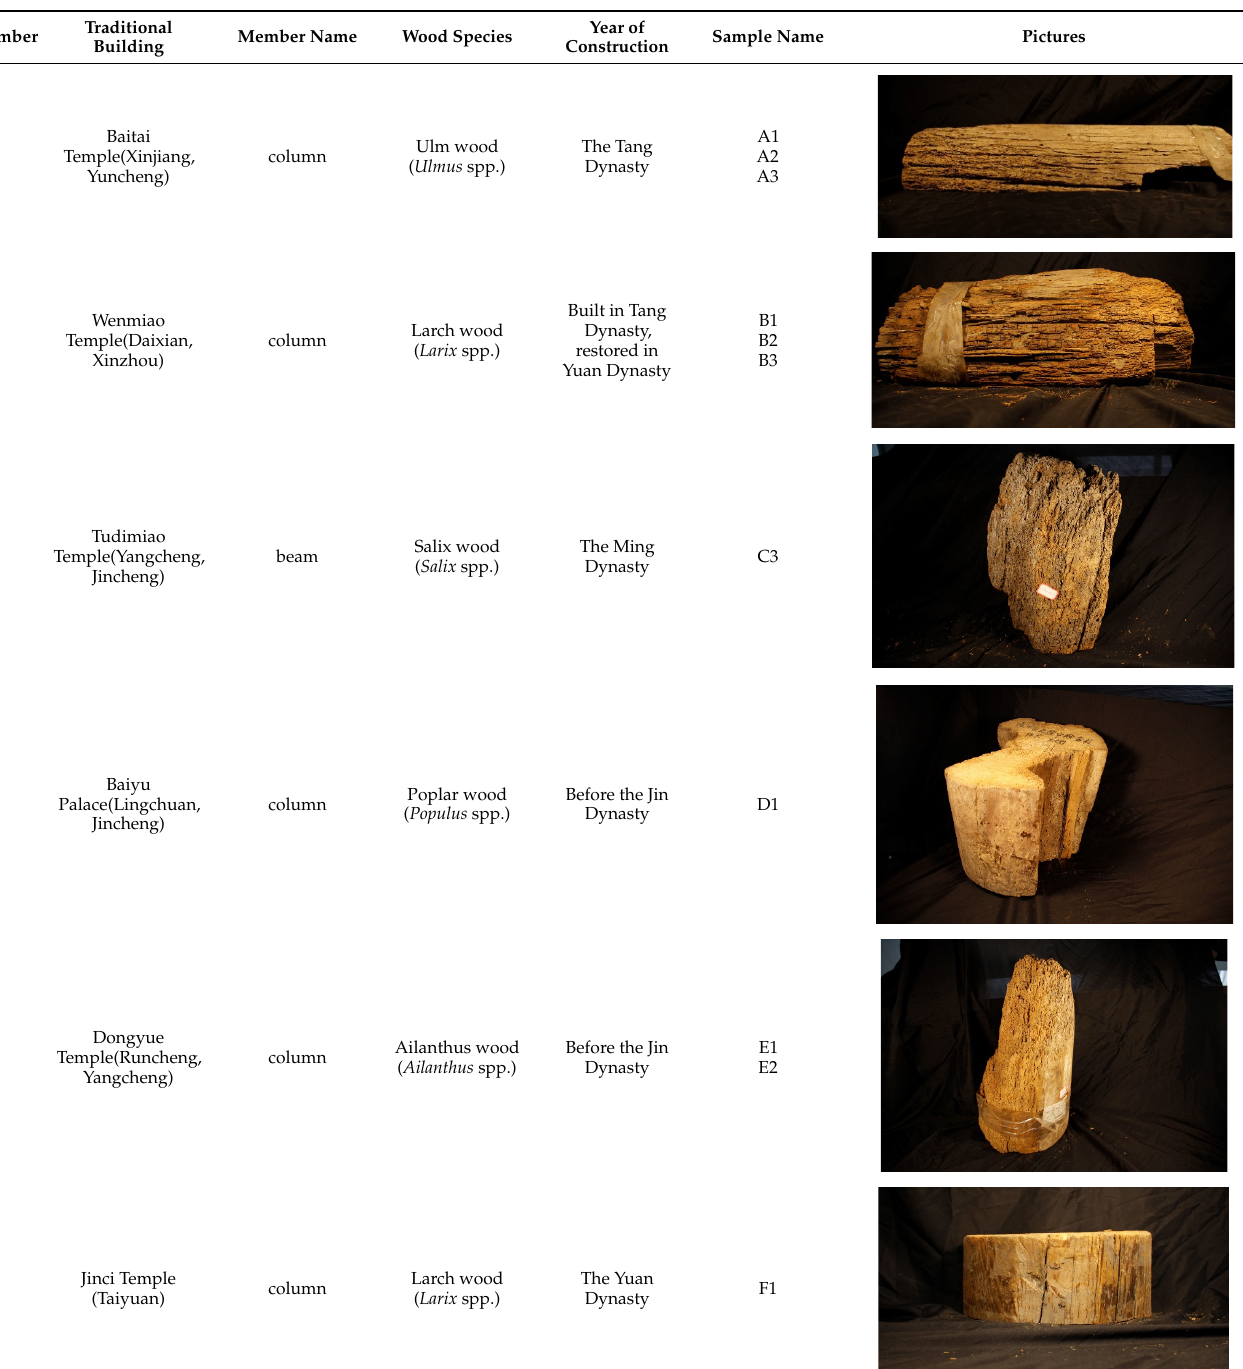
Table 1. Sample Information.